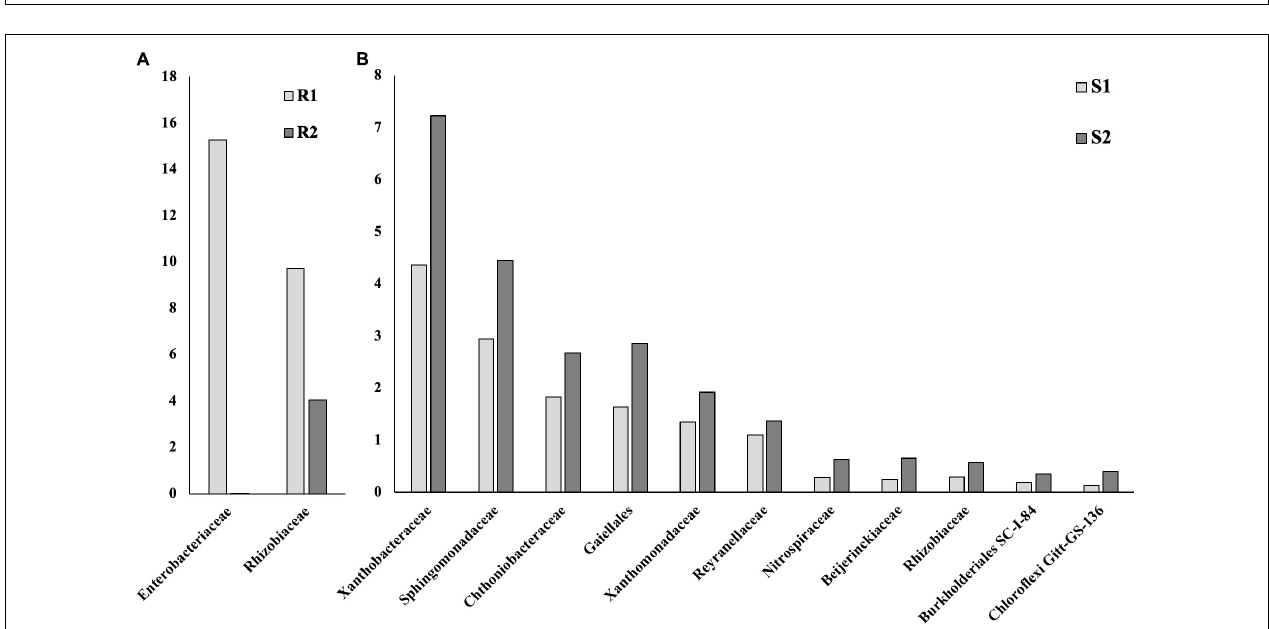
FIGURE 4 | Bacterial taxa that were differentially represented between roots (R), rhizospheres (RS), and soils (S) after different periods of plant growth. Based on the ALDEx2 Benjamini–Hochberg corrected p -value of the Kruskal–Wallis test. (A) Roots. (B) Rhizosphere. (C) Soil.